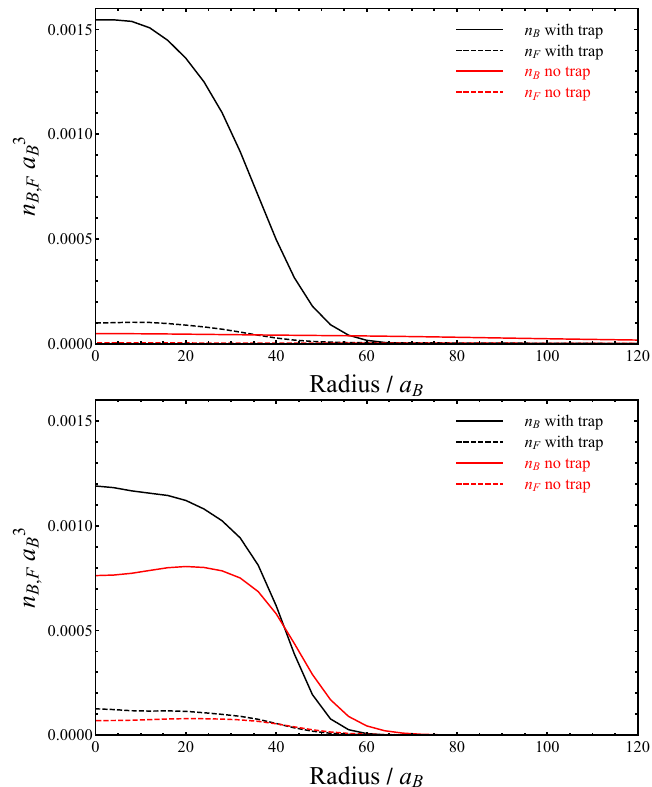
Figure 5: Bosonic densities (solid lines) and fermionic densities (dashed lines) for 35 fermions and 350 bosons – in the harmonic trap (black) and in the free space (red), / a = − 2 (upper panel) and a / a = − 4 for the mutual scattering length: a BF B BF B (lower panel). In the upper panel it is clearly visible that if the trap is removed the atoms are uniformly smeared over the entire grid. Fermionic density is so low that it is out of scale and is not visible in figure. Contrary, in the lower panel, after the atoms are released from the trap the densities reach equilibrium values corresponding to stationary